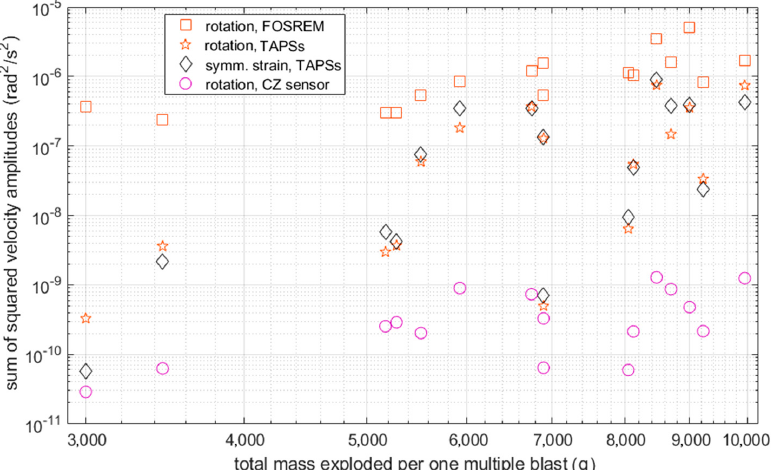
Figure 12. Sums of the squared velocity amplitudes of: rotations recorded with FOSREM and with the set of TAPSs, symmetric strain from the latter and rotation recorded with the CZ sensor with liquid. All are shown in (rad/s) 2 and plotted against the total masses in grams per each of the studied 16 multiple blasts that were directed vertically down. Signals from all the sensors except FOSREM were multiplied by suitable coefficients, as shown in the legend, in order to make their relative position